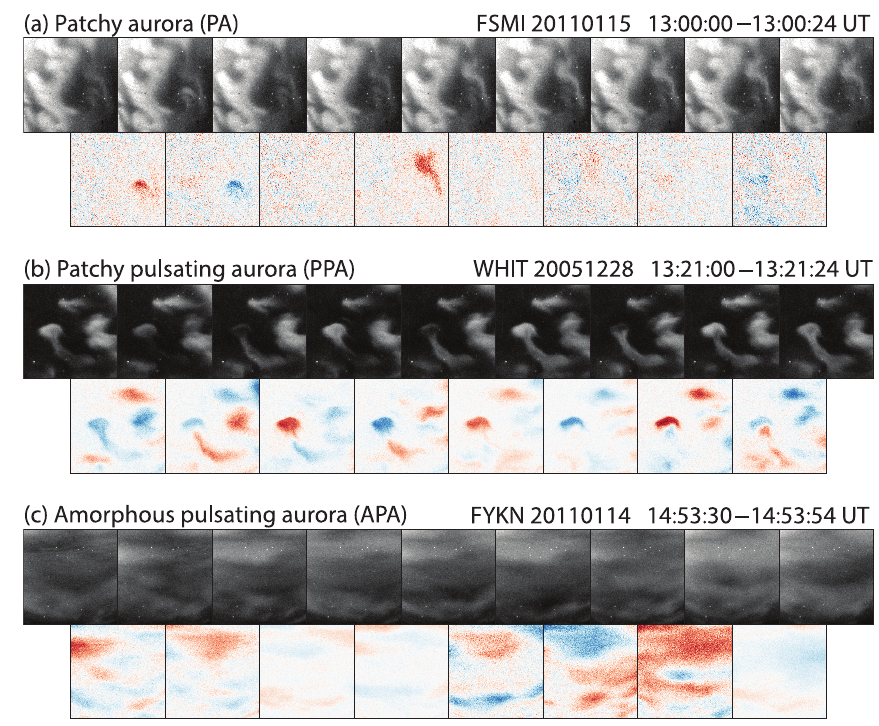
Figure 2. Series of images containing (a) patchy aurora, (b) patchy pulsating aurora, and (c) amorphous pulsating aurora as well as difference images highlighting the intensity modulations between sequential frames. Red and blue pixels indicate brightening and dimming,